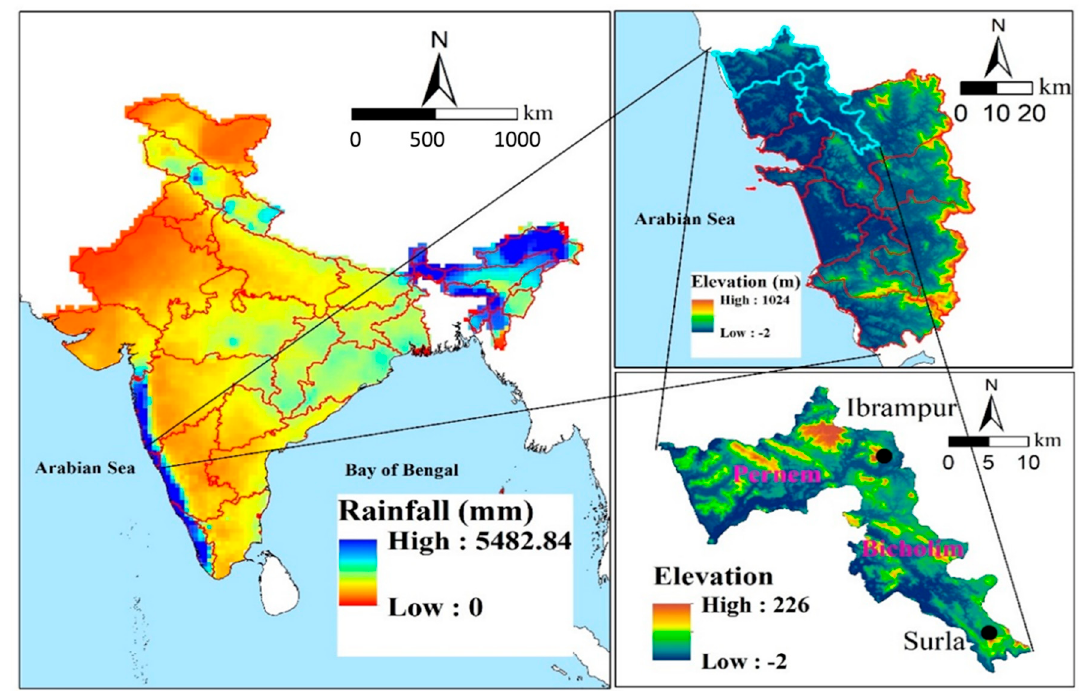
Figure 2. Map of the study area (15.2993° N, 74.1240° E).